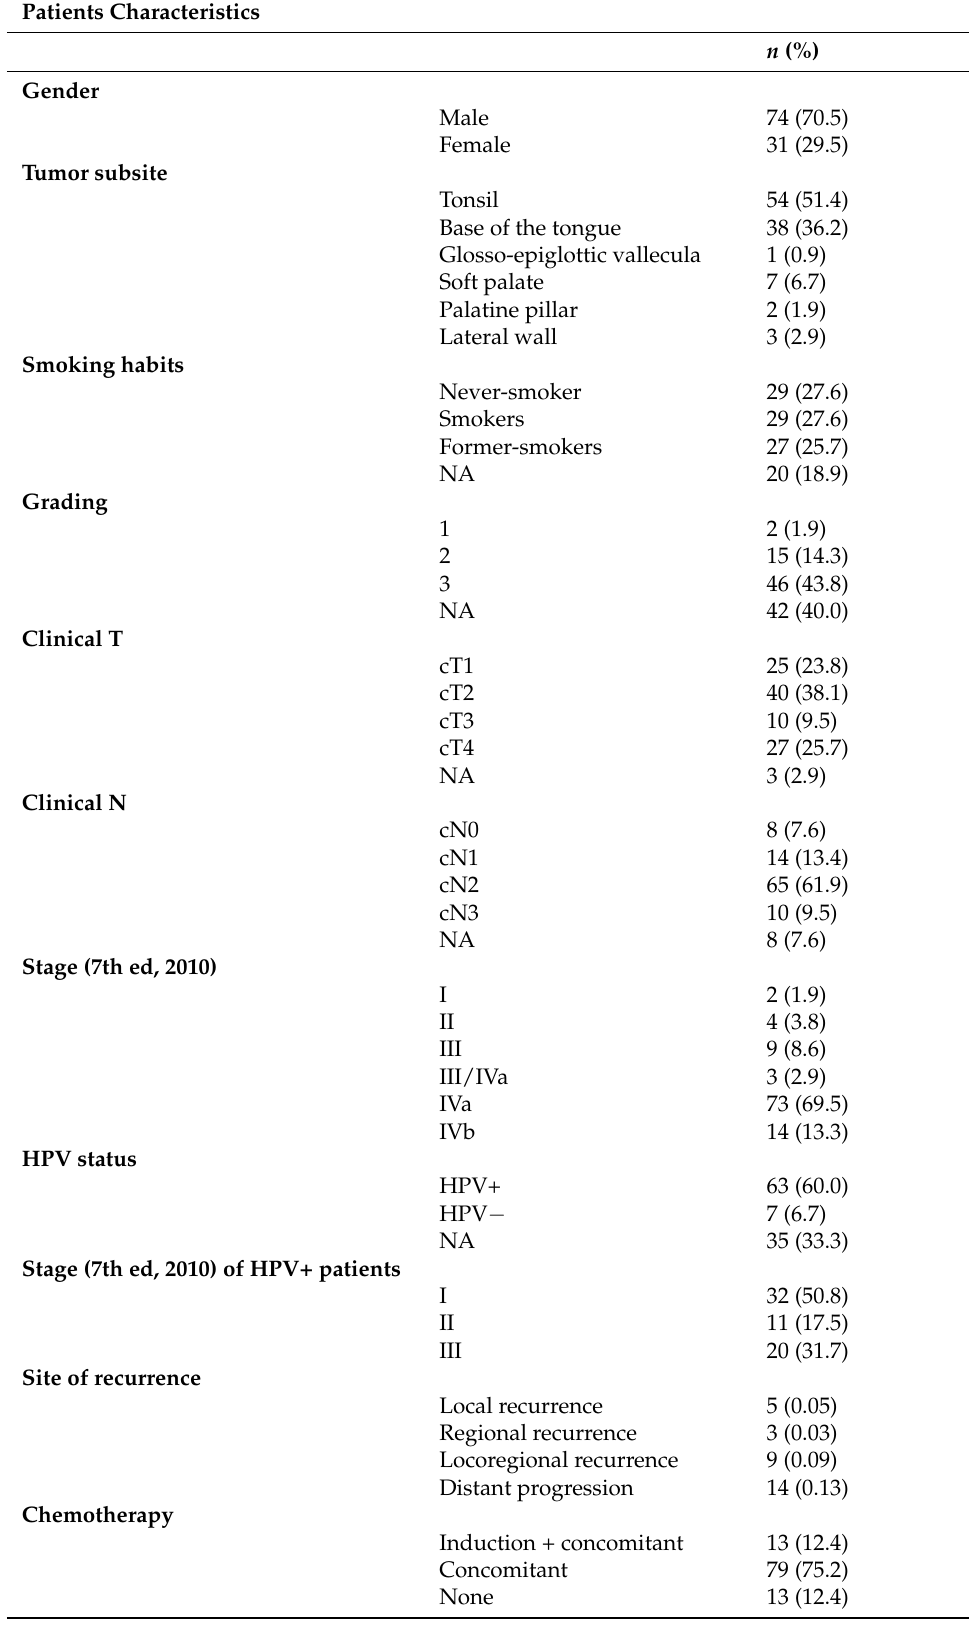
Table 1. Patient cohort